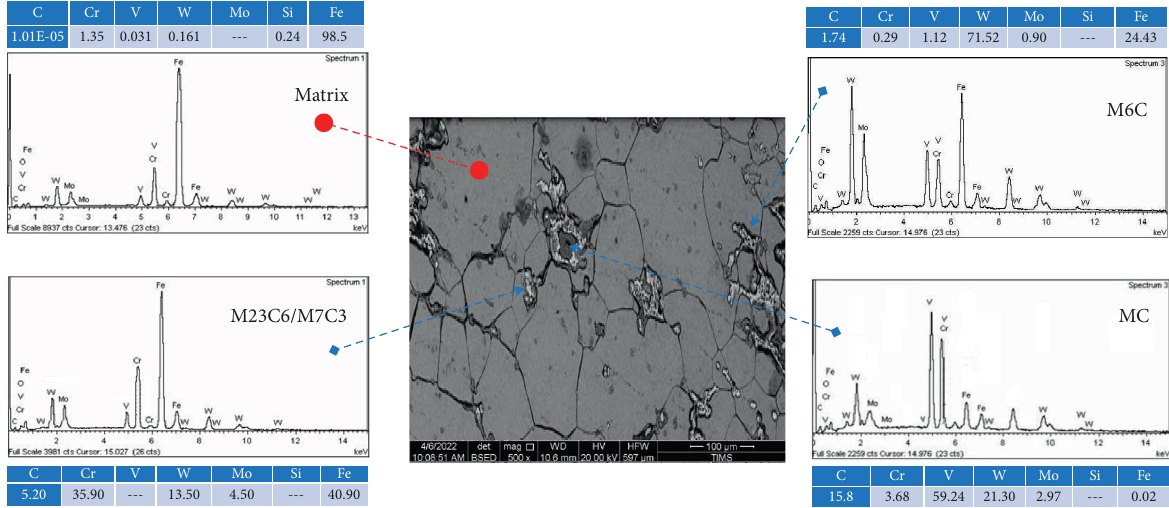
Figure 13: Carbon-vanadium-modifed high-speed tool steel. Table 3: Chemical composition of MC carbide for T1 high-speed tool steel and its diferent variants (as